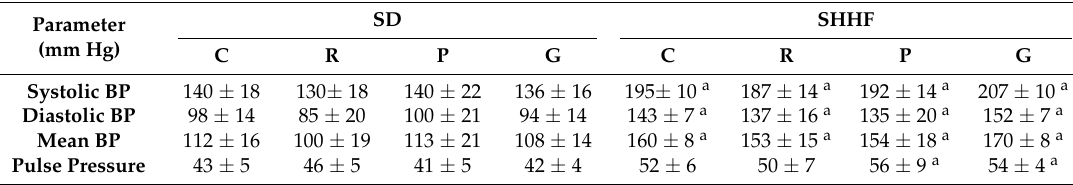
C—control, R—resveratrol, P—pterostilbene, G—gnetol. a p < 0.05 vs. SD controls.